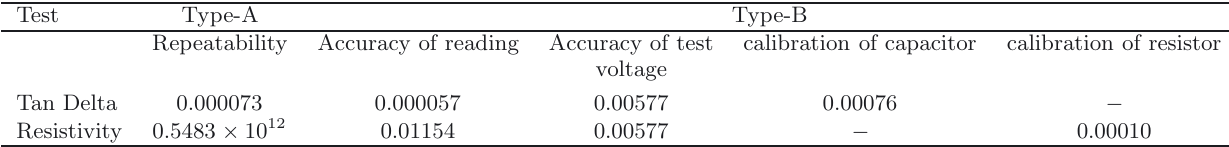
Table 8. Effects of individual factors for two